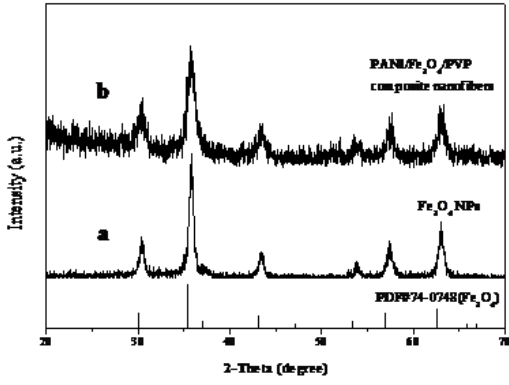
Fig. 1 XRD patterns of Fe nanofibers (b) with PDF standard card of Fe